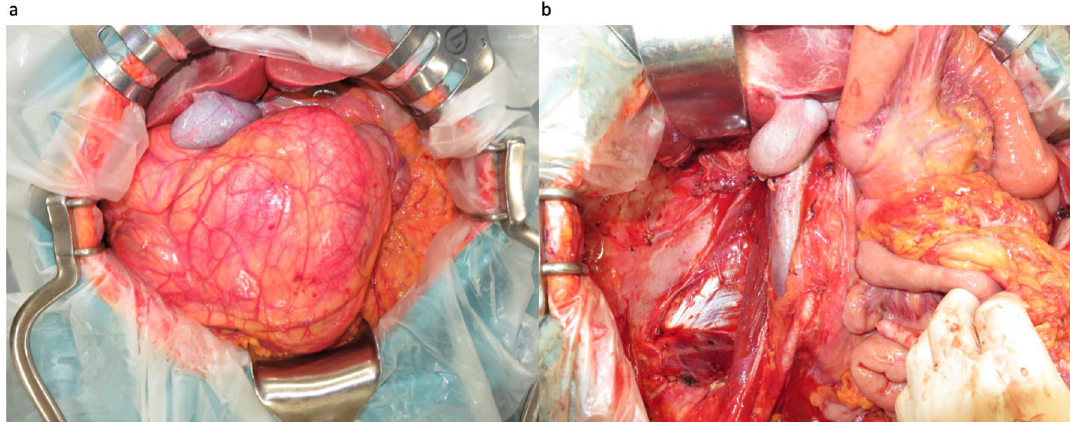
Fig. 2 Intraoperative findings. The tumor was tightly adherent to the liver, duodenum, transverse colon, and inferior vena cava ( a ). The tumor, right kidney, and the fat in the right retroperitoneal space were completely excised ( b )